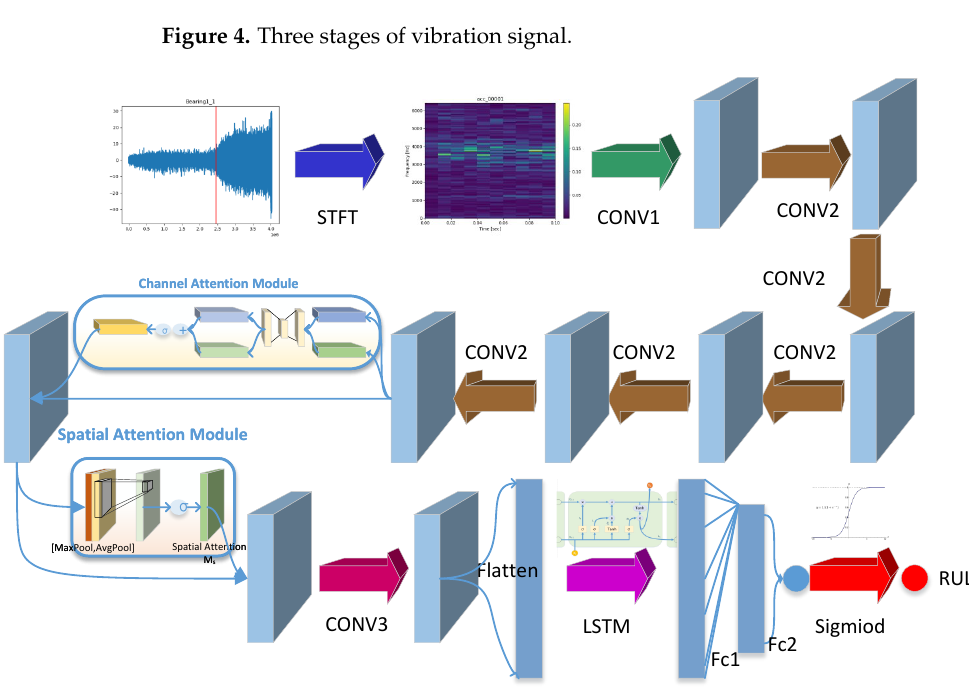
Figure 5. Structure of SAL-CNN Firstly, the vibration signal is preprocessed by STFT transformation (the size of the time-frequency diagram is 11 × 129 after preprocessing), enters into a six-layer convolution operation, and then into CBAM. After that, a one-layer convolution operation with a convolution kernel is used to compress the information, followed by LSTM. The last layer is a full connection layer and outputs a predicted life value; Table 1 describes specific network